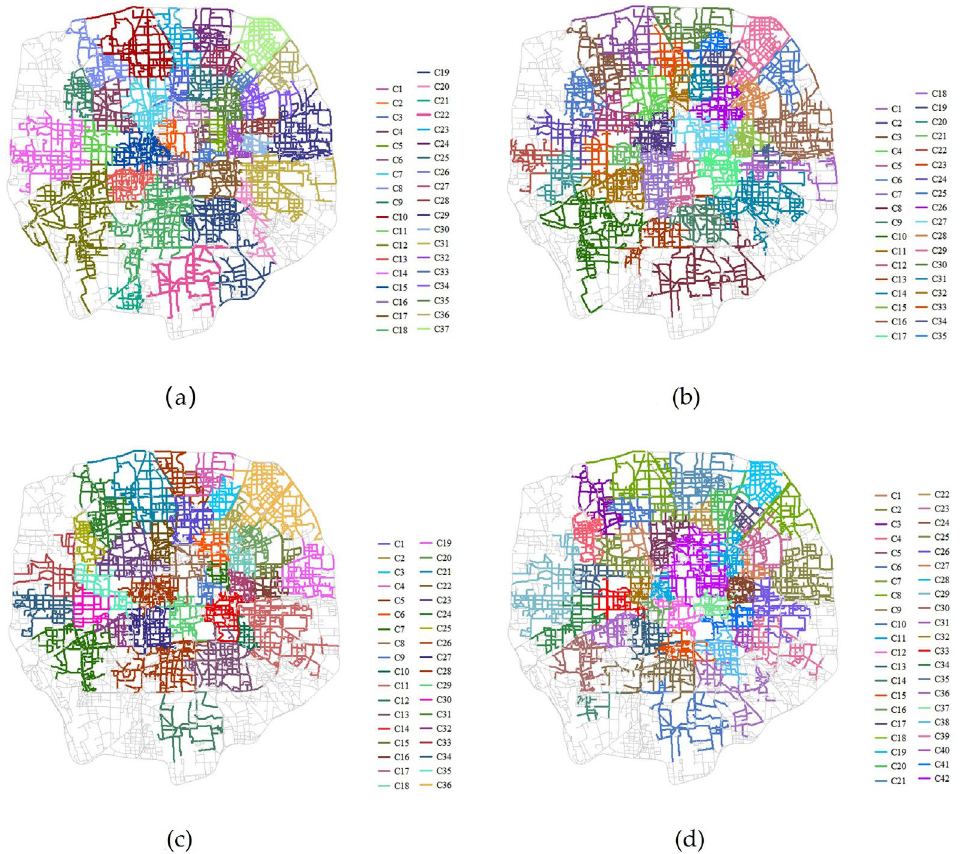
Figure 11. Low-resolution spatial communities discovered by the two methods during afternoon rush hours: ( a ) spatial communities identified by the proposed method on Monday; ( b ) spatial com- munities identified by Scleiden+ on Monday; ( c ) spatial communities identified by the proposed method on Sunday; and ( d ) spatial communities identified by Scleiden+ on Sunday.